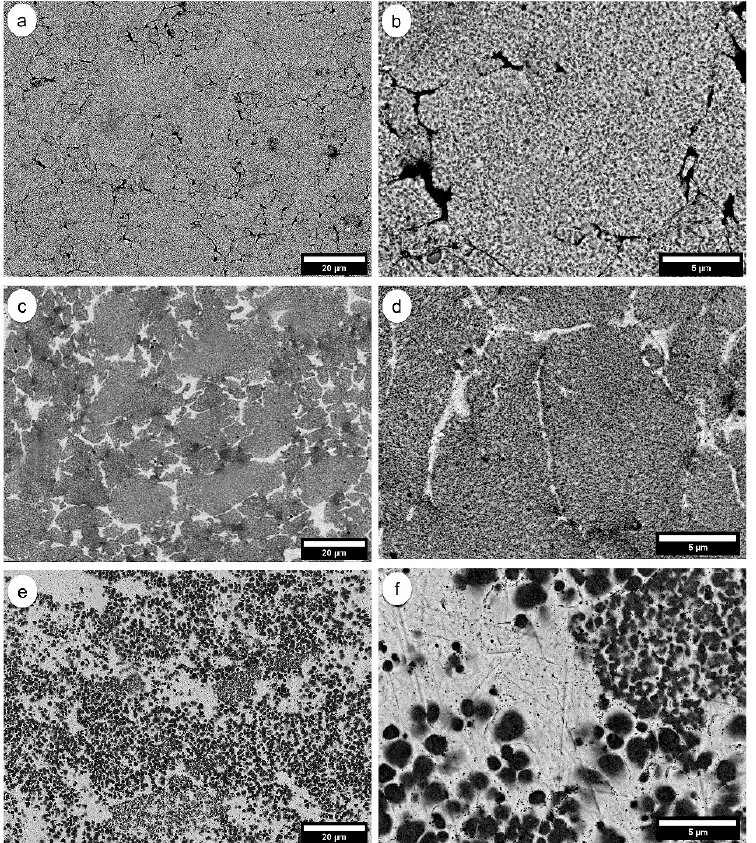
Figure 3. Microstructure of the sample core: ( a , b ) after being heated up to 473 K, before being subjected to a high current amplitude; ( c , d ) FSPS_1 and ( e , f ) FSPS_2.